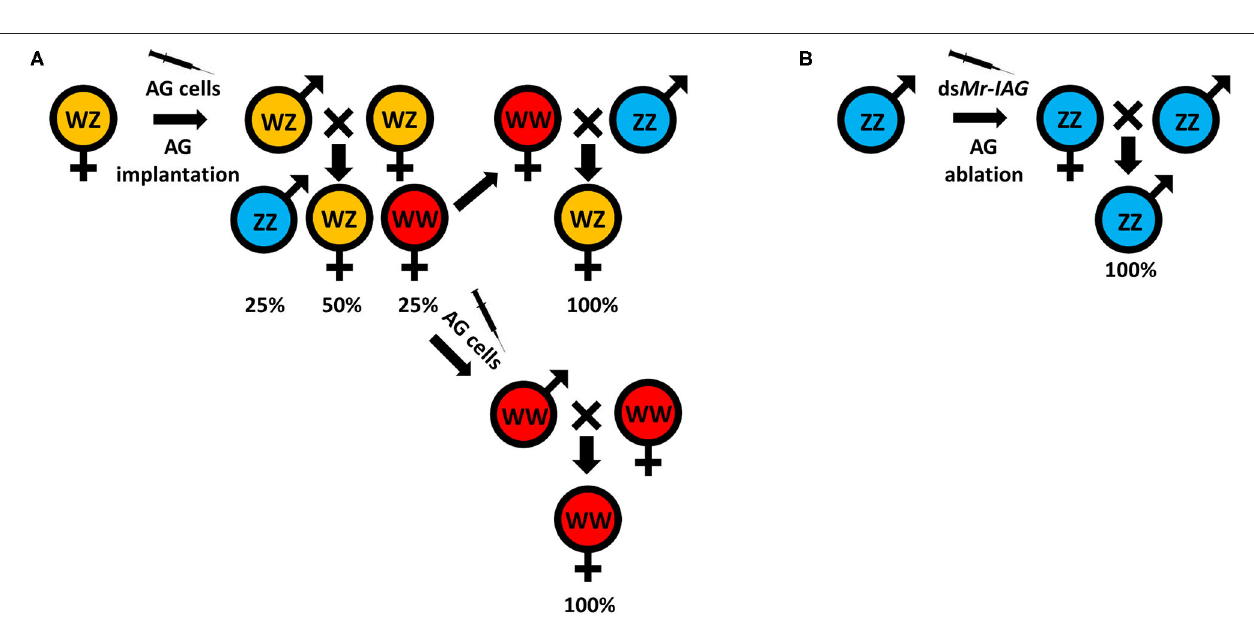
FIGURE 2 | Sex manipulation schemes for monosex populations: (A) all-male and (B) all-female in animals with the WZ/ZZ genotypic mode of inheritance; and (C) all-female and (D) all-male in animals with XX/XY genotypic mode of inheritance.